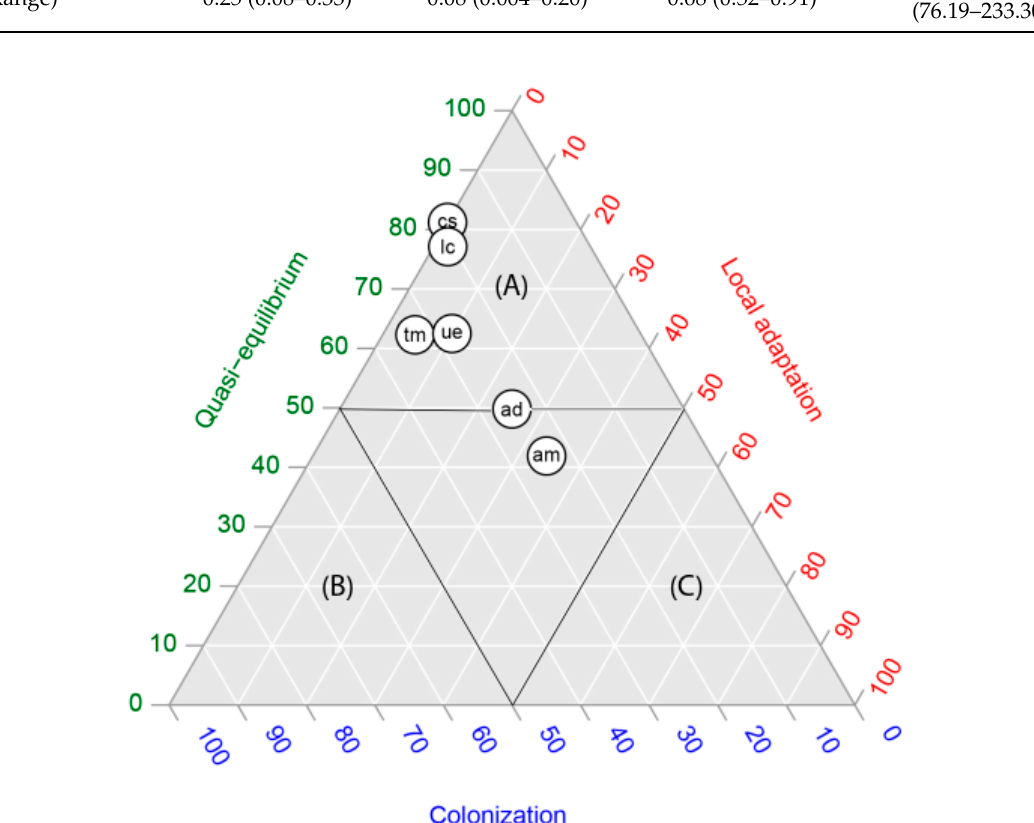
Figure 1. Ternary plots of the proportion of presences (the niche space) depicting the relative position of six alien leguminous species: Acacia dealbata (ad) , A. melanoxylon ( am) , Cytisus striatus ( cs) , Teline monpessulana ( tm) , Ulex europaeus ( ue) and Lotus corniculatus ( lc), central Chile, in relation to quasi-equilibrium, local adaptation and colonization stages. Capital letters represent zones dominated by quasi-equilibrium ( A ), colonization ( B ) and local adaptation ( C ).